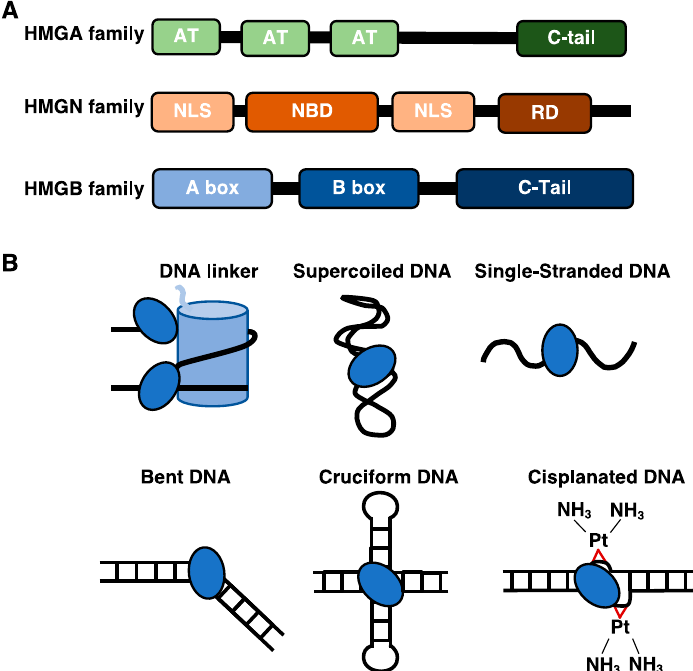
Figure 1. ( A ) Schematic showing the domains in HMG family proteins. Abbreviations: AT, AT hook; C-tail, C-terminal acidic tail; NLS, nuclear localization sequence; NBD, nucleosomal binding domain; RD, regulatory domain; A box, HMG box A; and B box, HMG box B. ( B ) HMGB1/2 can bind to a myriad of DNA structures. The light blue cylinder represents a nucleosome, and the dark blue ovals represent HMGB1/2.